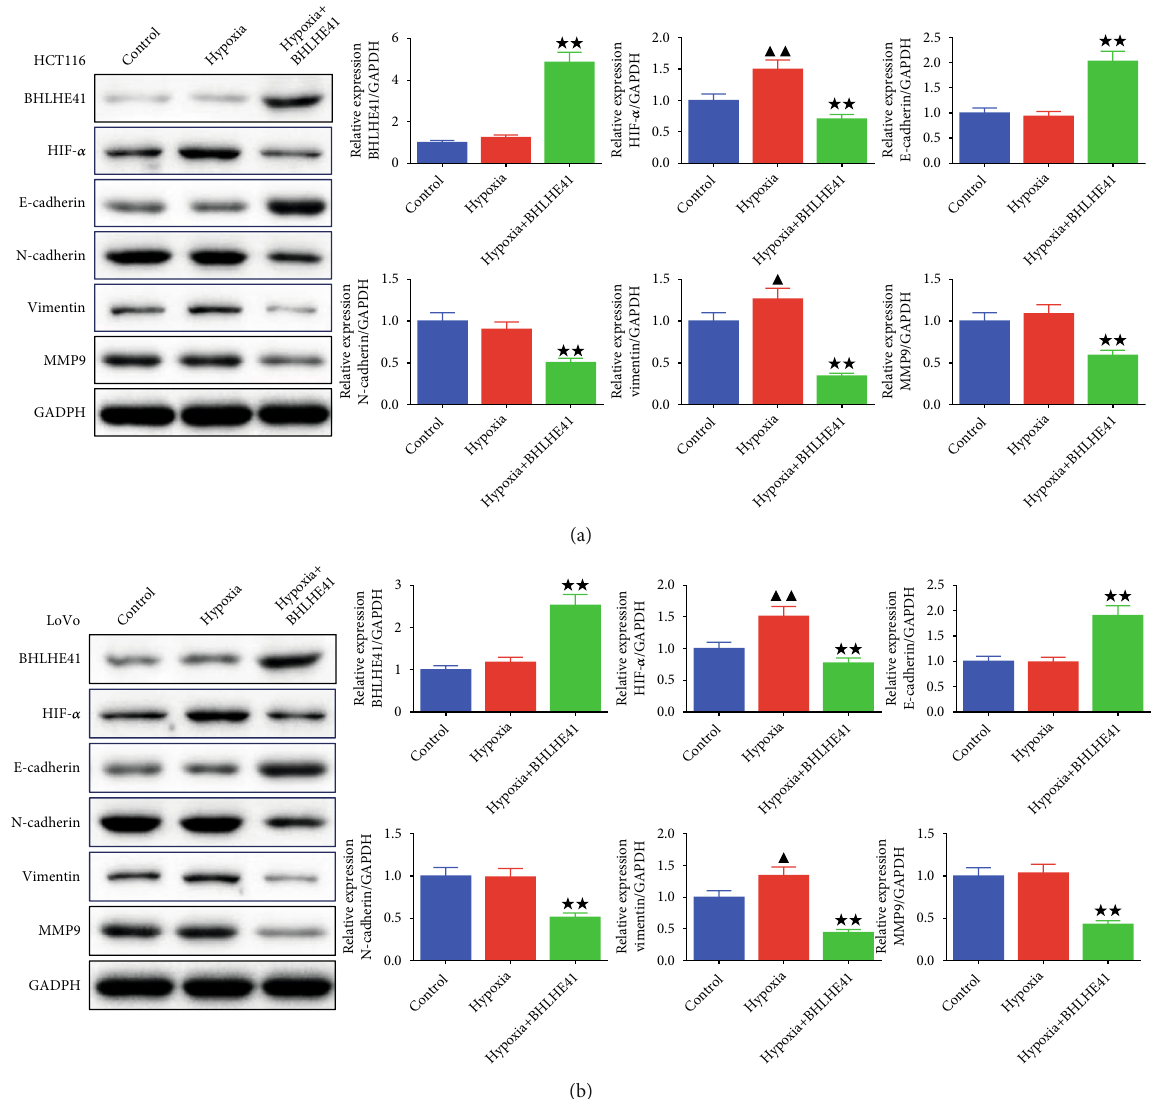
Figure 8: BHLHE41 overexpression weakened the HIF-1 α and EMT-related factor levels in hypoxia-induced CC cells. (a) and (b). The BHLHE41, hypoxia-inducible factor-1alpha (HIF-1 α ), and epithelial-mesenchymal transition- (EMT-) related factor levels in hypoxia- induced CC cells were tested by Western blot. All experiments have been performed in triplicate, and data were expressed as mean ± SD . ∗∗ P < 0 : 01 vs. hypoxia; ▲ P < 0 : 5 , ▲▲ P < 0 : 01 vs.